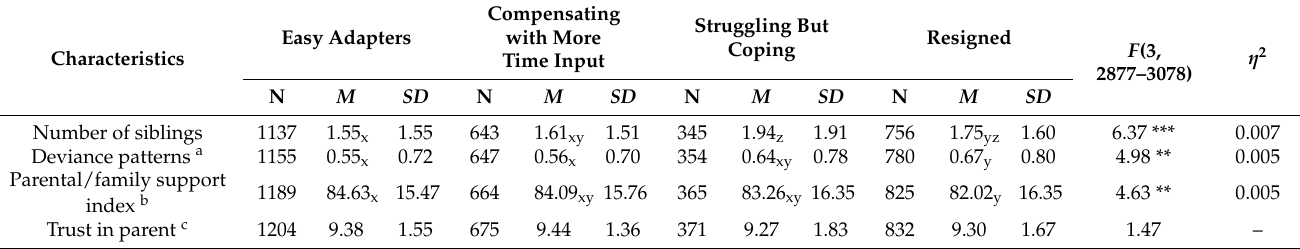
Table 4. Means, standard deviation and one-way ANOVA by family background characteristics.